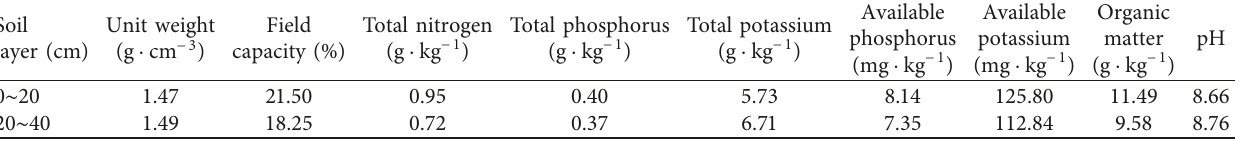
Table 1: Physical and chemical characteristics of soil in the test